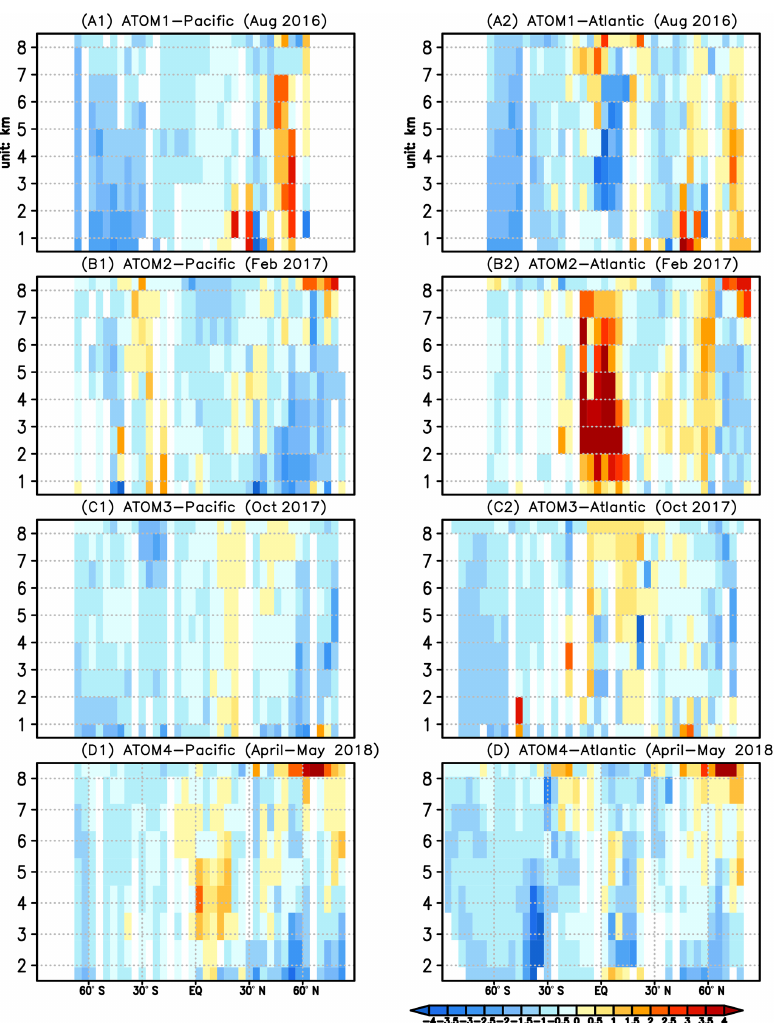
Figure B6. Differences between posterior CO 2 and ATom 1–4 aircraft CO 2 observations over the Pacific (A1–D1) and Atlantic Ocean (A2– D2) as a function of latitude and altitude (unit: km). Unit: ppm.